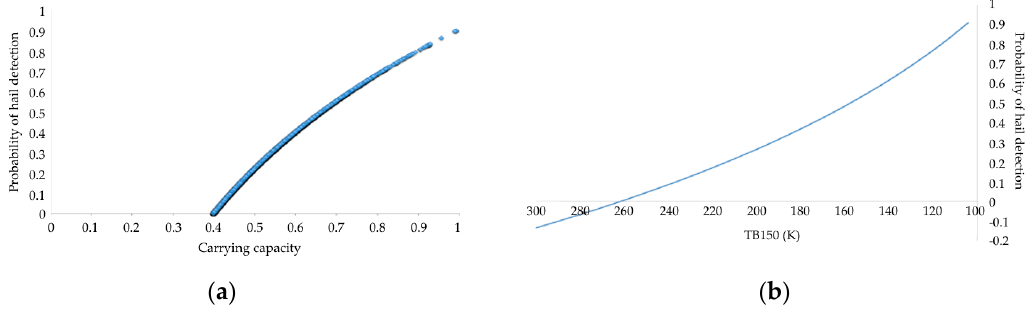
Figure 8. Distribution of hail probabilities calculated from eq. 4 when applied to the whole dataset ( a ) and the hail model as a function of TB150 ( b ).